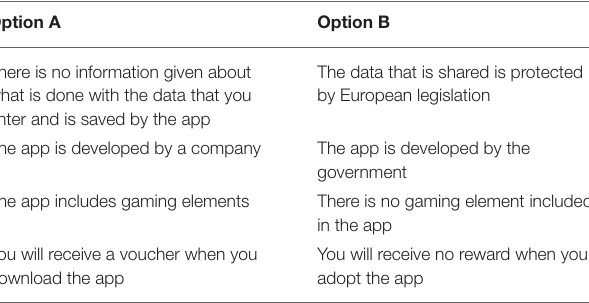
TABLE 2 | One example of the discrete choice task participants had to complete. Option A